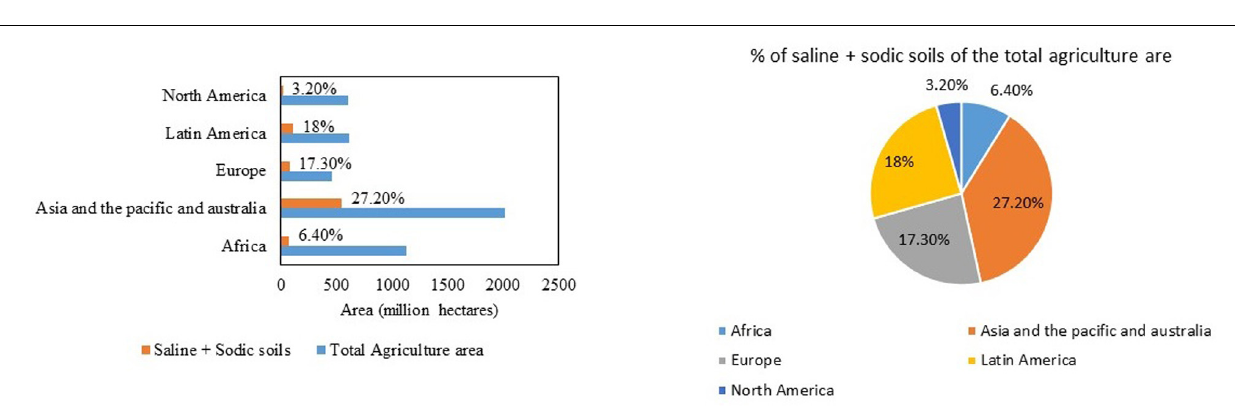
FIGURE 4 | Area of the total agricultural land in different continents that has sodic and saline soil (in millions of hectares of land) (FAO, 2019; Chauhan et al.,